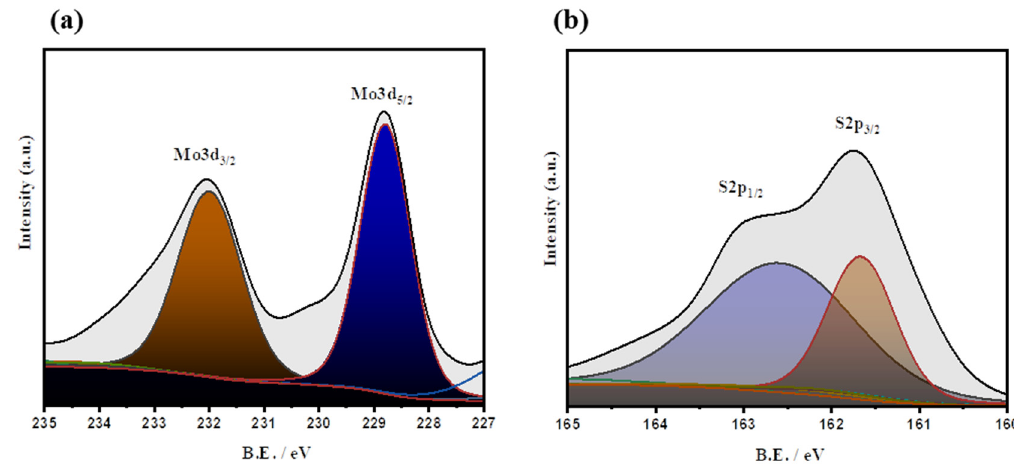
Figure 2. Mo3d ( a ) and S2p ( b ) XPS spectrum of the prepared MoS 2 .